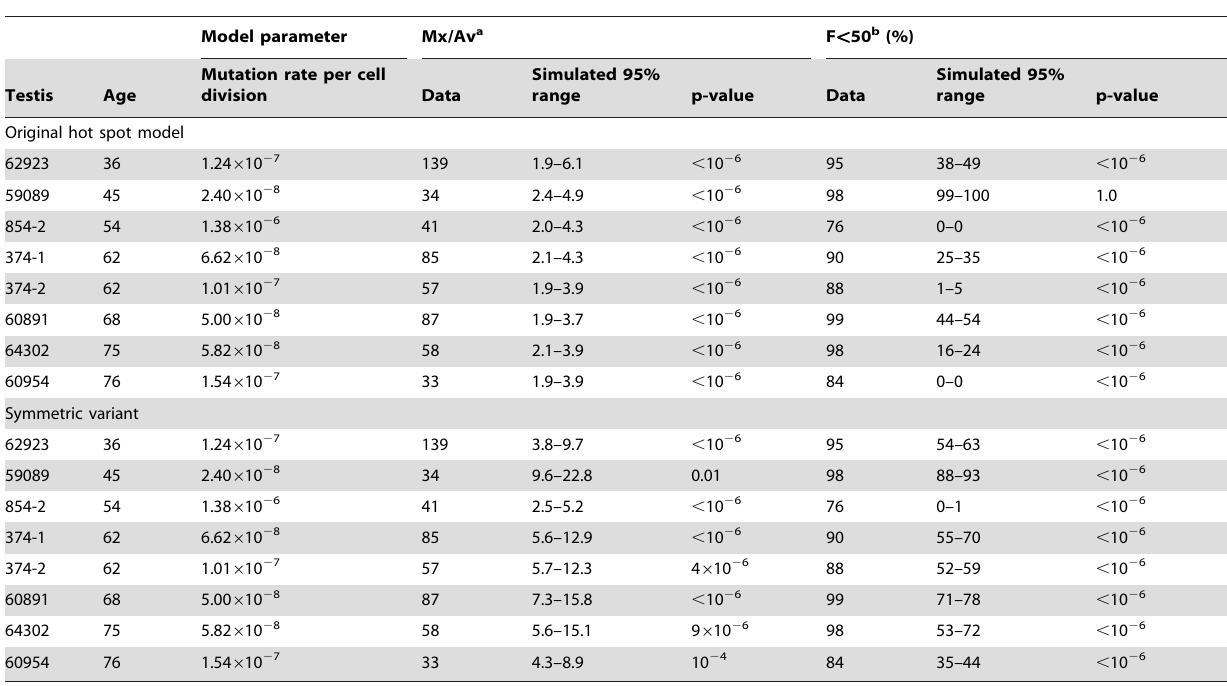
Table 2. Hot spot model parameter and simulation results for those testes with substantial MEN2B mutation clusters.